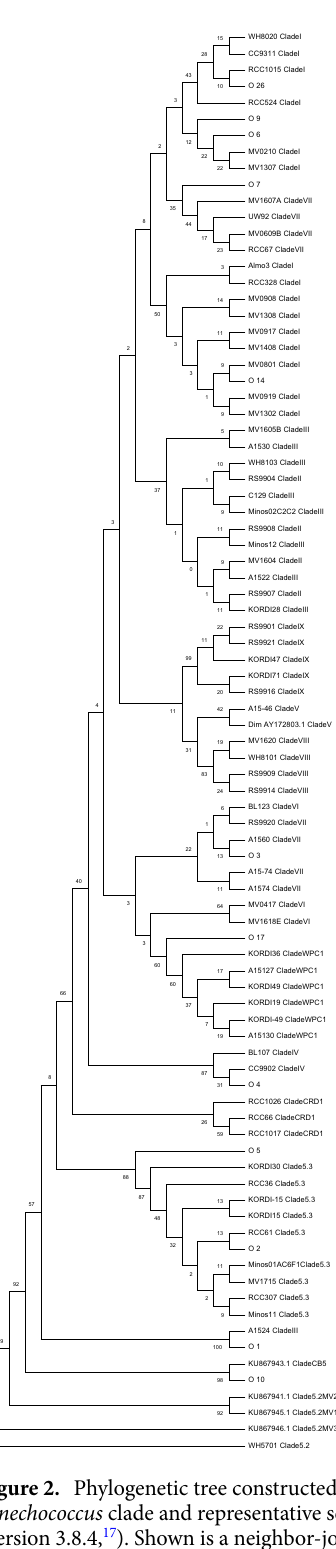
Figure 2. Phylogenetic tree constructed from V4–V5 16S rRNA gene amplicon sequence representatives of Synechococcus clade and representative sequences for the most abundant oligotypes, both aligned using Muscle (version 3.8.4, 17 ). Shown is a neighbor-joining rooted tree generated using the Geneious Prime 2021.1 software package (Biomatters Ltd, Auckland, New